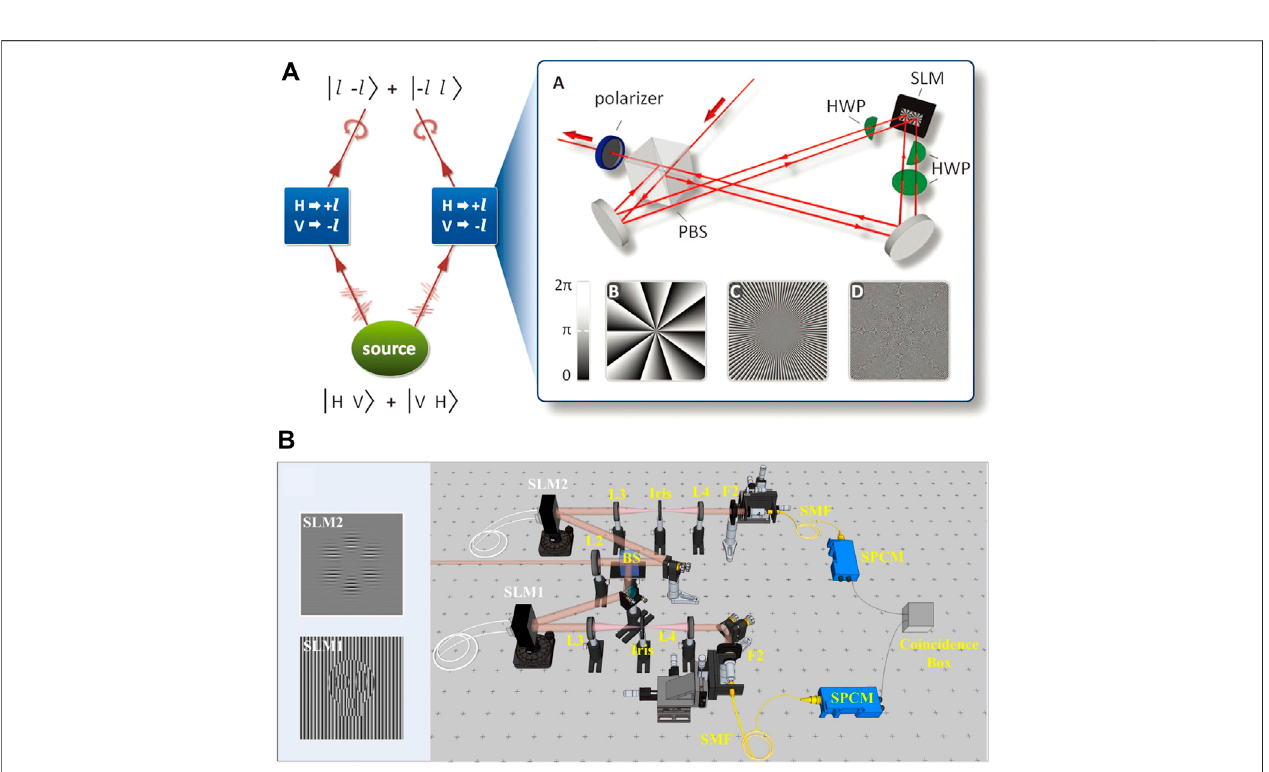
FIGURE 6 | RDE in quantum optics. (A) Quantum entanglement of high order angular momenta [26]. (B) Quantum remote sensing of the angular rotation of structured objects [74]. It suggests potential applications in developing a noncontact way for angular remote sensing of object.